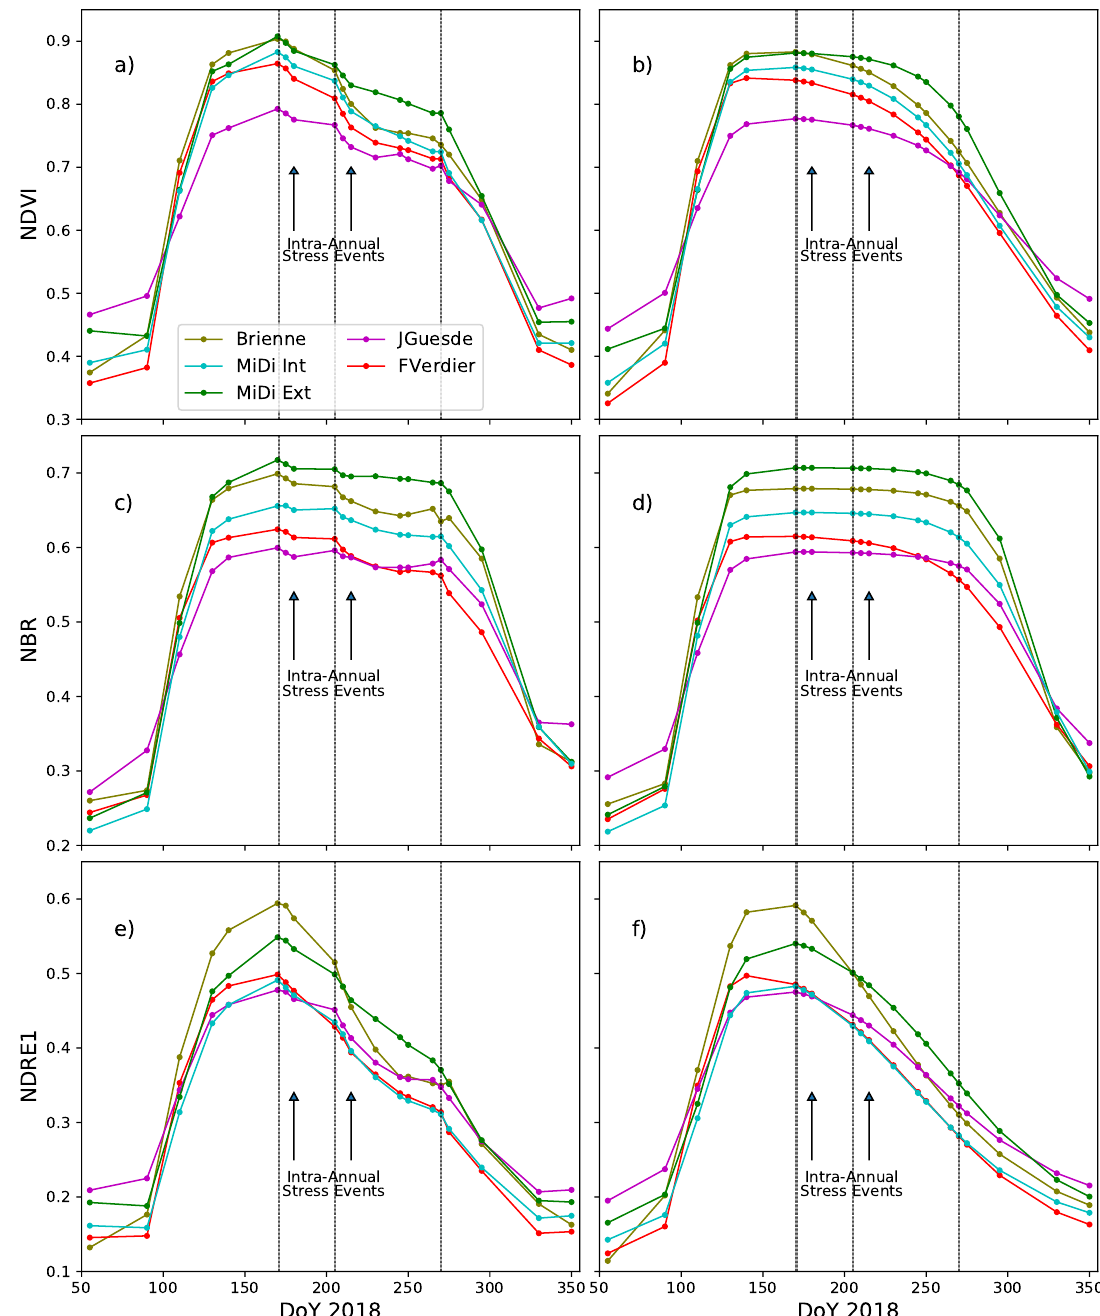
Figure 9. Reconstruction of the 2018 London plane phenological curves with Savitzky–Golay filtering as described by NDVI ( a ), NBR ( c ) and NDRE1 ( e ) and with double logistic fitting as described by NDVI ( b ), NBR ( d ) and NDRE1 ( f ), both applied on the vegetation pixels of the five studied areas: Canal de Brienne (olive), Urban Canal de Midi (cyan), Peri-Urban Canal de Midi (green), J. Guesde (magenta) and F. Verdier (red). Black dashed vertical lines indicate DoY 170, 205 and 270 corresponding to the start dates of the two intra-annual phenological disturbance periods and the end of the second one